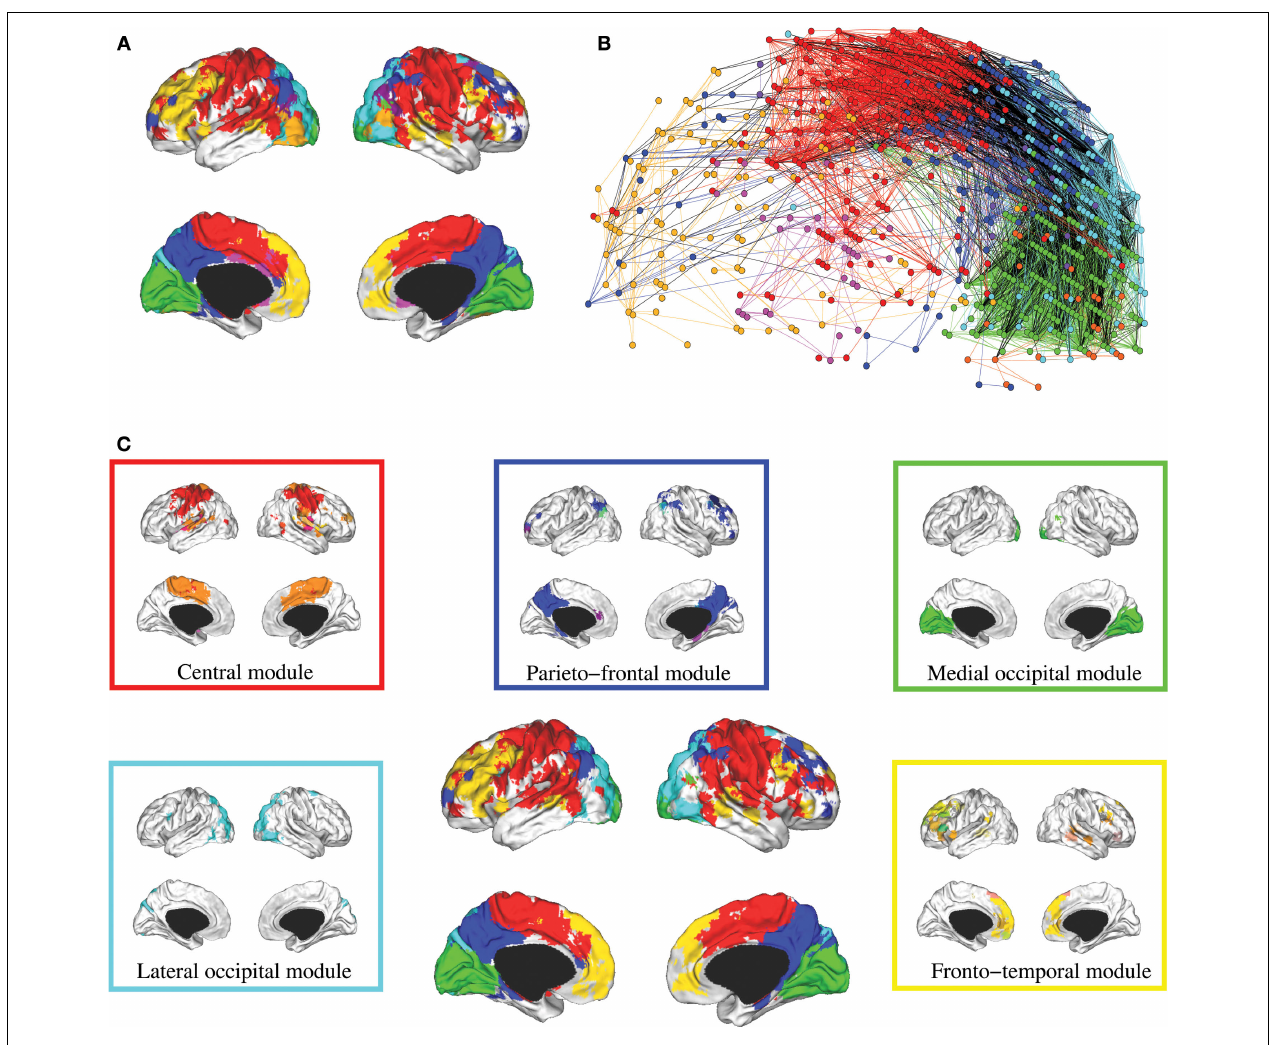
FIGURE 3 | Hierarchical modularity of a human brain functional network. (A) Cortical surface mapping of the community structure of the network at the highest hierarchical level of modularity, showing all modules that comprise more than 10 nodes. (B) Anatomical representation of the connectivity between nodes in colour-coded modules. The brain is viewed from the left side with the frontal